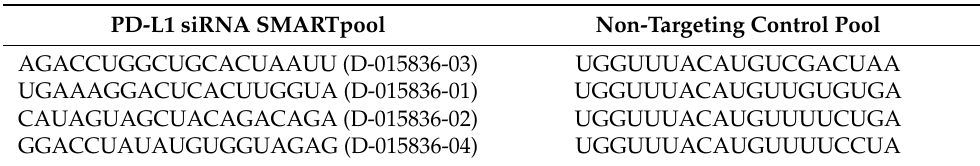
Table 1. SiRNA sequences used for PD-L1 knockdown